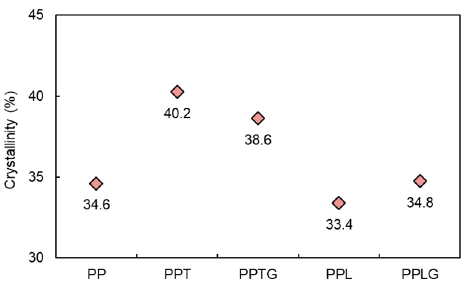
Figure 4. The crystallinity index of PP, PP/polyphenol blends, and PP/crosslinked polyphenol blends.